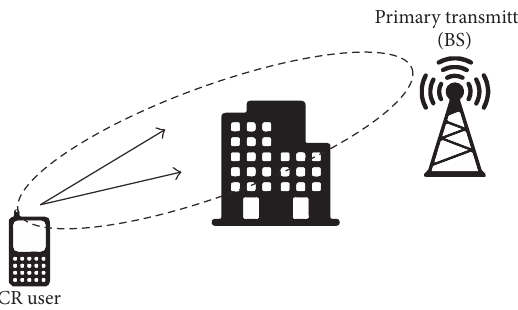
Figure 8: Occupancy time of forecasted GSM channel.